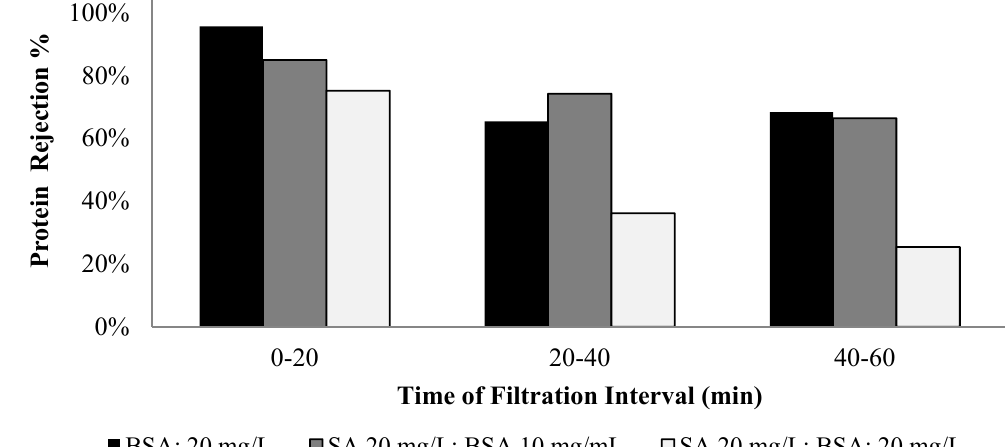
Figure 12. Protein rejection for filtration of solutions with different ratios of BSA to